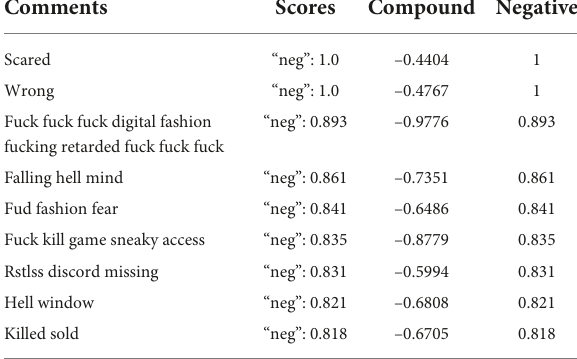
TABLE 5b Analysis results of negative attitude and content of related posts.